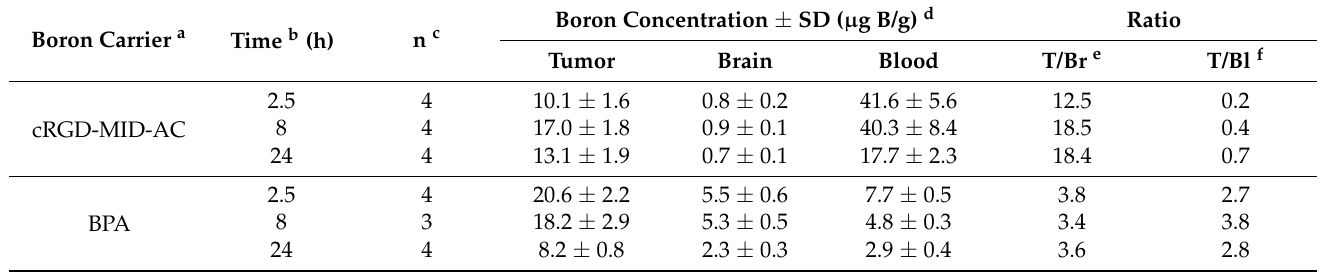
Table 1. Boron concentrations in the tumor, brain (normal brain), and blood after intravenous administration of each boron carrier in F98 glioma-bearing